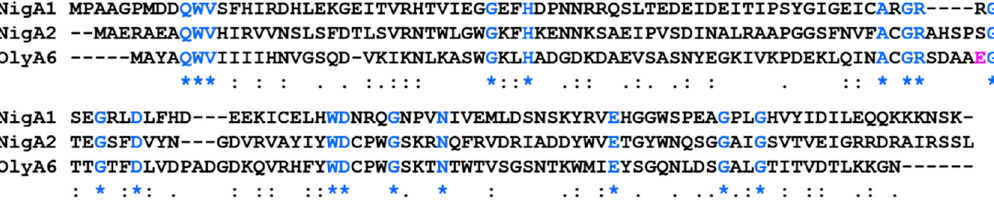
Figure 2. Alignment of nigerolysins A1 and A2, and ostreolysin A6 protein sequences. NigA1 and NigA2, nigerolysin A1 and A2, respectively; OlyA6, ostreolysin A6. In blue, identical amino acid residues (by ClustalW). In magenta, a single glutamic acid residue enables the specific recognition of cholesterol-associated sphingomyelin in OlyA6.